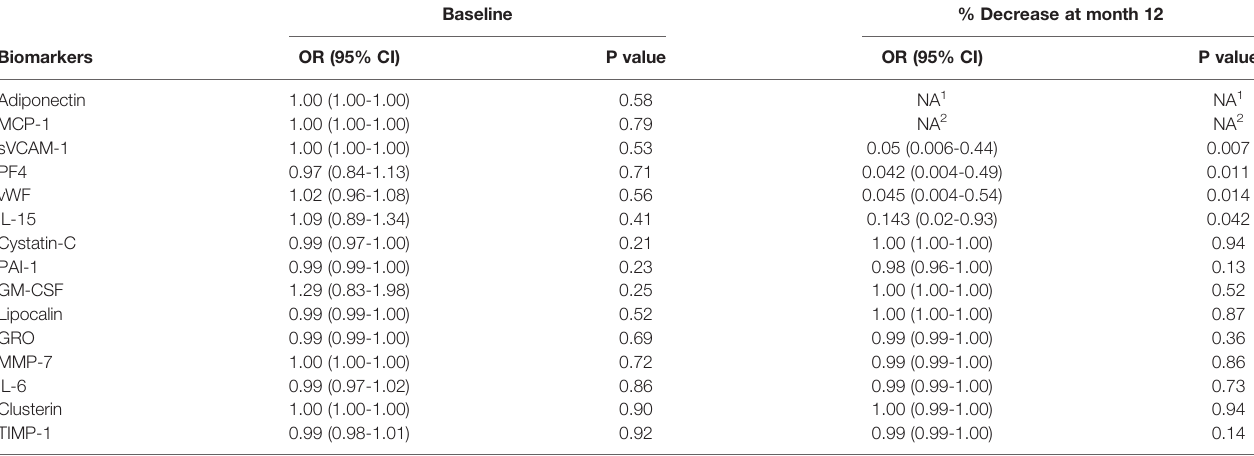
TABLE 2 | Logistic regression analysis assessing baseline levels and percentage decrease at 12 ± 3 months as predictors of complete response at month 24 for the urinary biomarkers. N = 21.